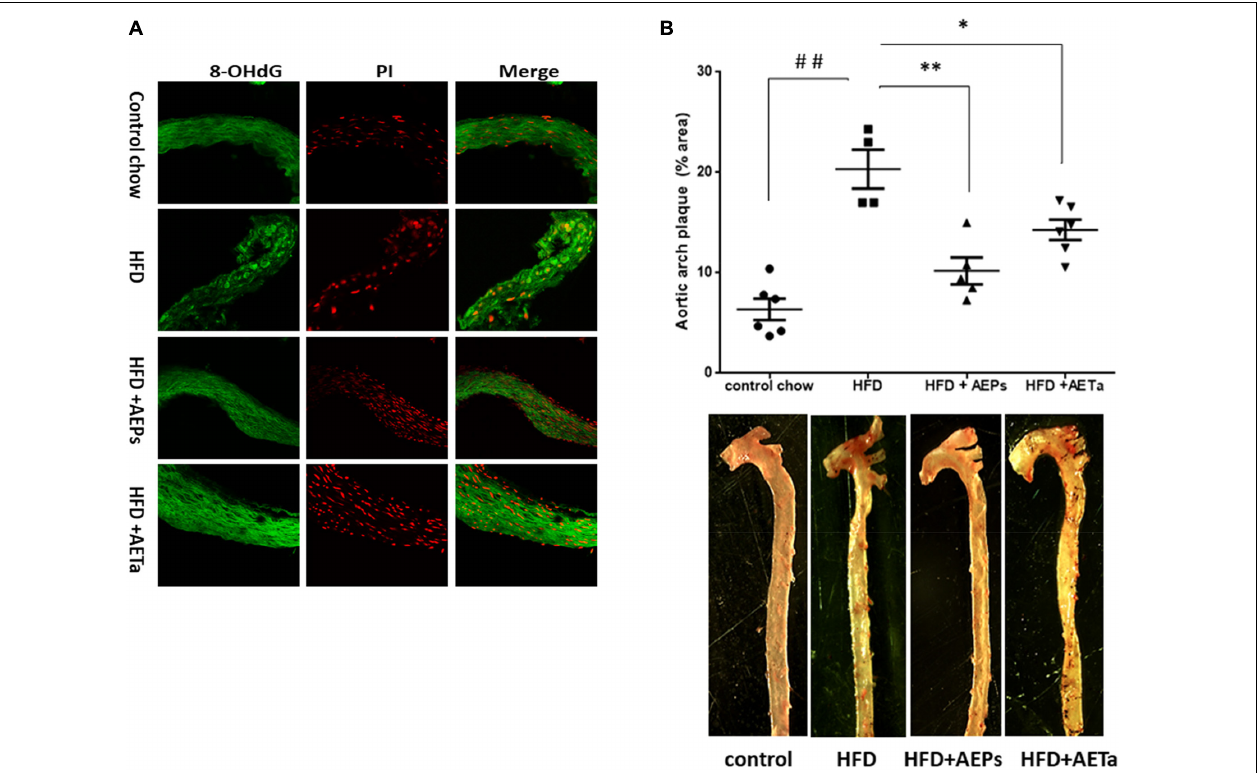
FIGURE 7 | Effect of Prosopis strombulifera or Tessaria absinthioides on the progression of atherosclerosis. ApoE-KO mice were fed during 8 weeks with control diet (CD), high-fat diet (HFD), and HFD plus AEPs or AETa (150 or 300 mg/kg/day, respectively) in the drinking water in the last 4 weeks. After sacrifice, whole aortas were excised to determine (A) expression of 8OH-dG, a marker of oxidative damage of DNA. Representative photomicrographs of cross sections of the aorta of mice submitted to immunofluorescence reaction for 8-OHdG; PI, propidium iodide as nuclear marker. (B) Atheroma plaque area in the aortic arch and thoracic portion. Anthropometric measure was performed by staining with oil-red O. Plaque area in the images was quantified using the ImageJ 1.50i software. Data are means ± SEM ( n = 4–6 mice per group). ## p < 0.001 vs. control chow; ∗ p < 0.05 and ∗∗ p < 0.001 vs. HFD. ApoE-KO, apolipoprotein E-knockout; AEPs, aqueous extract of P. strombulifera ; AETa, aqueous extract of T. absinthioides